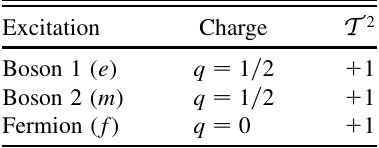
TABLE II. Symmetry properties of the topological excitations gauge theory, realized on the surface of a 3D SPT phase of a Z 2 with charge conservation and time-reversal symmetry ], as for the topological insulator. The bosonic quasi- [ U ð 1 Þ 2 Z T 2 particles carry half charge but transform linearly under time reversal. Further details are in Appendix